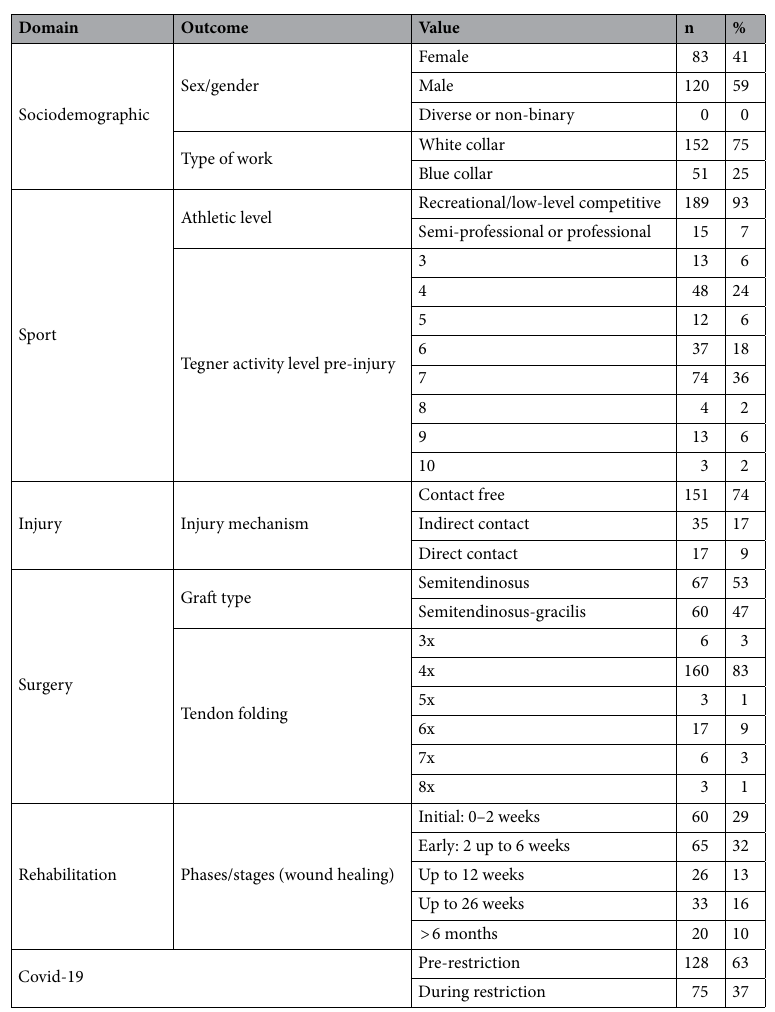
Table 1. Numeric and percentage distributions of all categorical sociodemographic, sport-, injury-, surgery- and pandemic-specific characteristics of the study sample. n numbers, % percentage